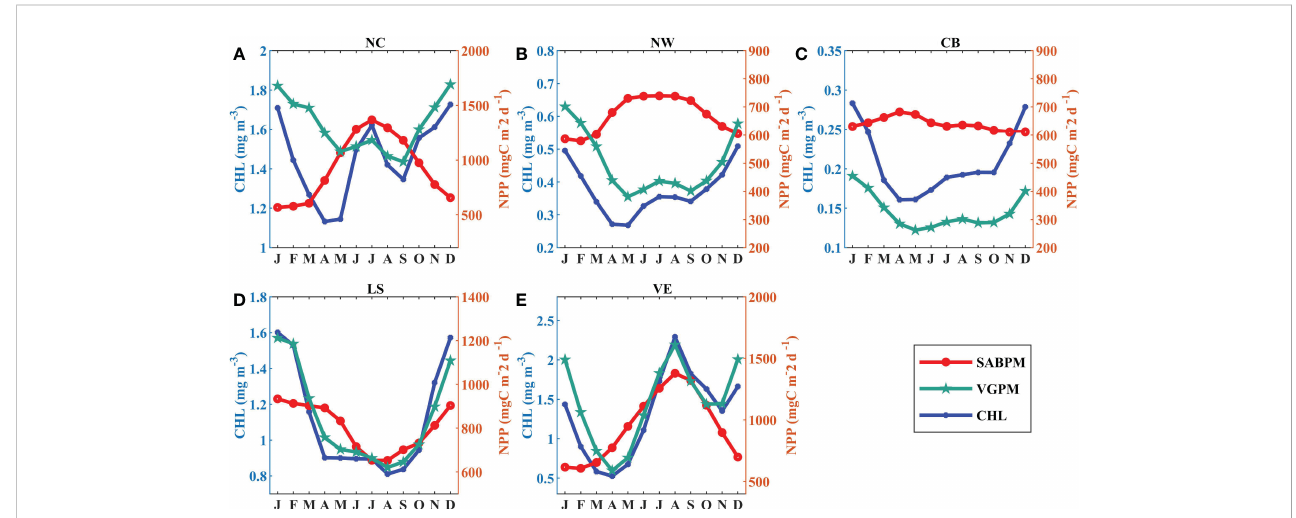
FIGURE 4 (A – E) Monthly average variations of mean NPP based on SABPM (red line), NPP based on VGPM (green line), and CHL (blue line) in the fi ve regions shown in Figure